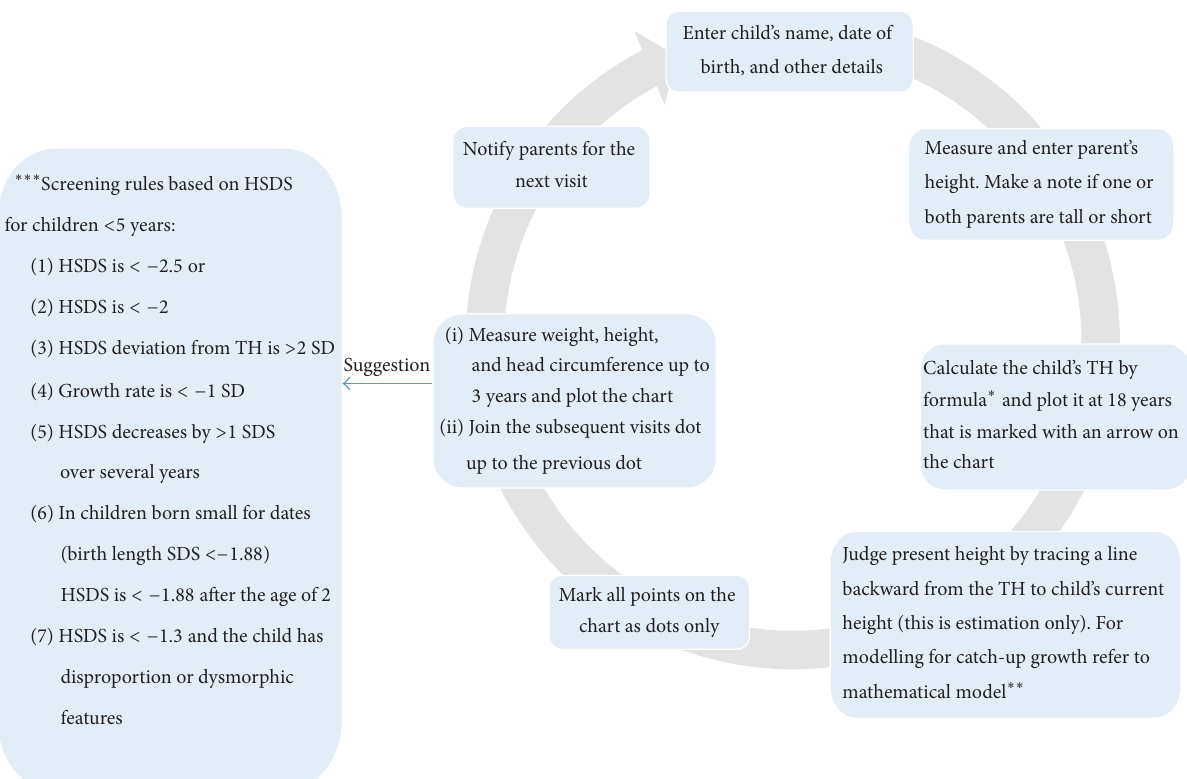
Figure 1: Guidelines for plotting growth charts as per guidelines from the Indian Academy of Pediatrics. ∗ Tanner et al. [11]; ∗∗ Boersma et al. [12]; ∗∗∗ van Buuren et al. [13]; Saari [14]. TH: target height; HSDS: height standard deviation score; SD: standard deviation; SDS: standard deviation